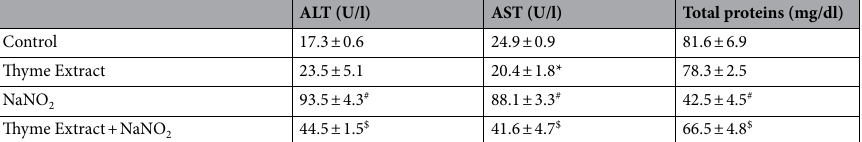
Table 4. Protective effects of Thymus vulgaris extract against NaNO 2 induced alteration in liver biomarkers in mice. Values are means ± standard error (SEM) for 7 different mice per each treatment. Values are statistically significant at * p < 0.05 versus control; # p < 0.05 versus control and thyme extract groups. $ p < 0.05 versus NaNO 2 . ALT: alanine transaminase; AST: aspartate